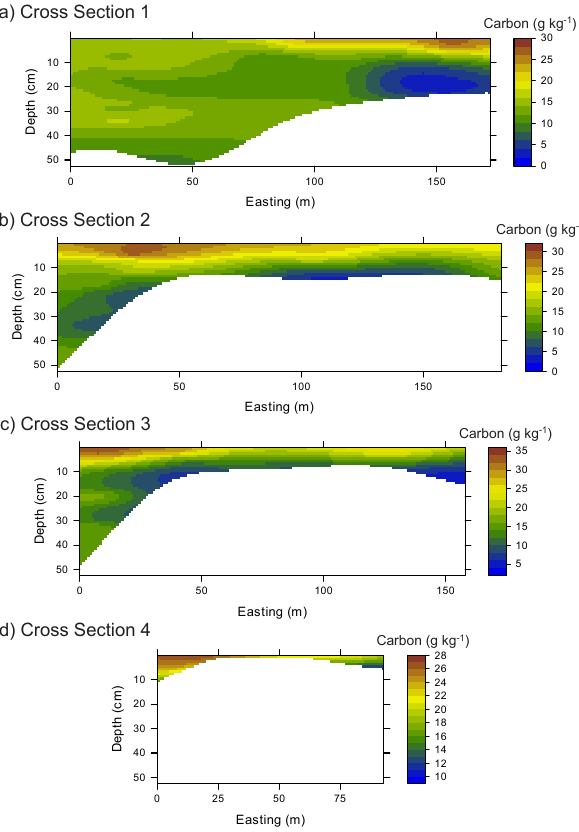
Fig. 9. Maps showing vertical cross-section of sediment carbon concentration along four transects running west to east. See Fig. 8 for cross section locations.